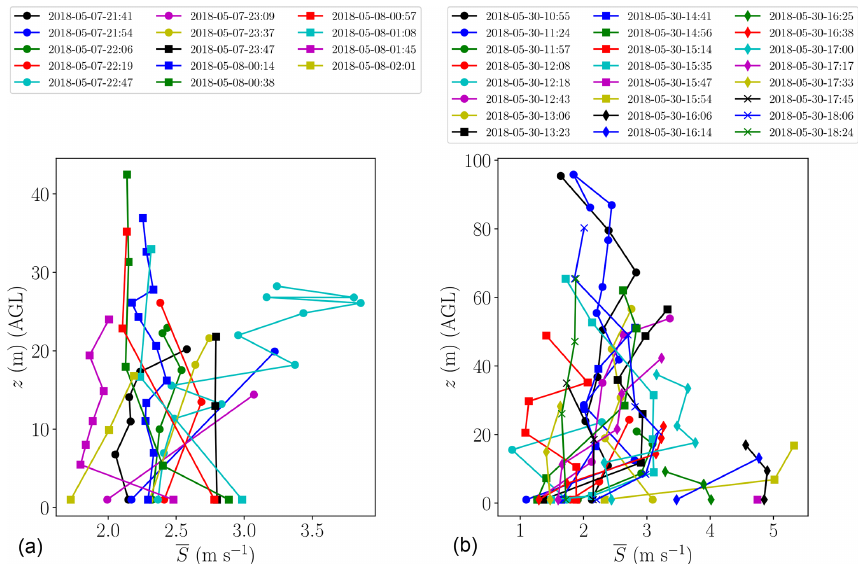
Figure 10. Vertical profiles of wind speed on 7, 8 and 30 May 2018. (a) Thermally stable condition at night and early morning, (b) thermally unstable condition at midday; times are in